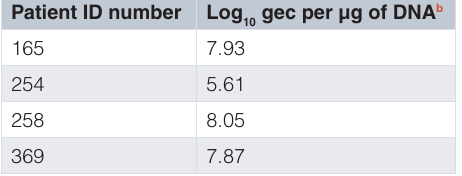
Table 2. Quantitative PCR results from hair follicle specimens for ciHHV-6 a positive